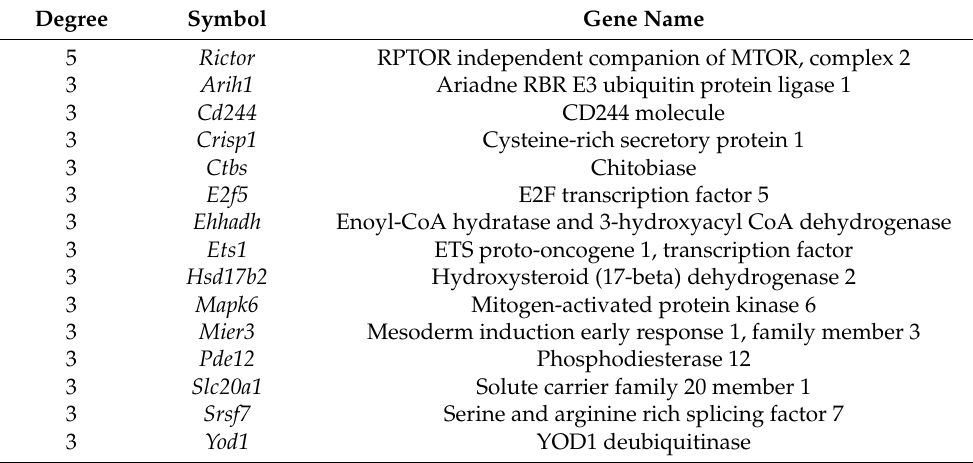
Table 1. Top listed predicted mRNA targets of ProtectomiR microRNAs revealed by interaction network and microRNA–mRNA target prediction analysis. From the total number of mRNAs regulated by up- or downregulated ProtectomiR microRNAs the listed 15 mRNAs had at least three microRNA–mRNA target interactions (node degree). Rictor , the target hub, was ranked first, involved in five microRNA–mRNA target interactions (degree 5). (Complete list of predicted target mRNAs is available in the Supplementary Materials (Supplementary Table